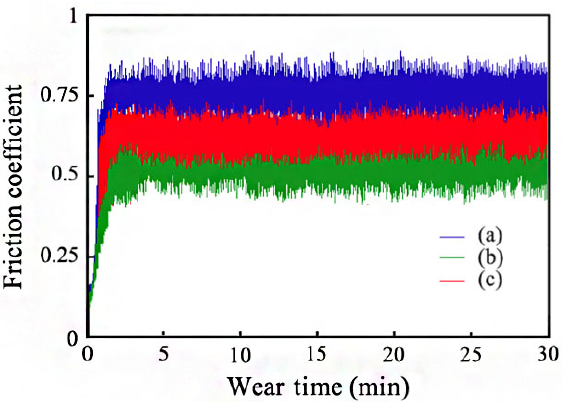
Figure 10. Coefficients of friction for Ni/TiN-SiC nanocomposites generated with diverse pulse current densities: ( a ) 2 A/dm 2 , ( b ) 4 A/dm 2 , and ( c ) 6 A/dm 2 .